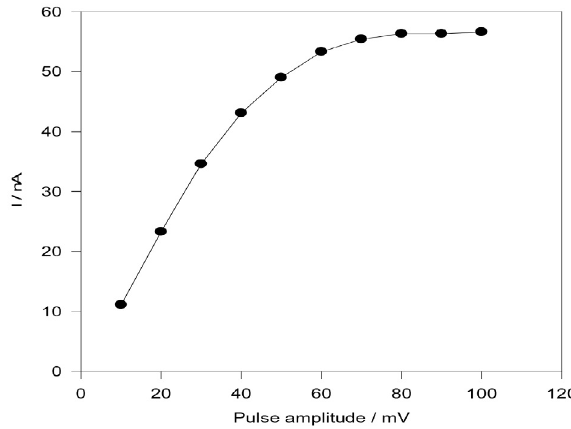
Figure 4. Effect of pulse amplitude on the oxidation current for 3.98 × 10 -6 mol/L chlorzoxazone in 0.04 mol/L BR buffer pH 6.5 and scan rate of 50